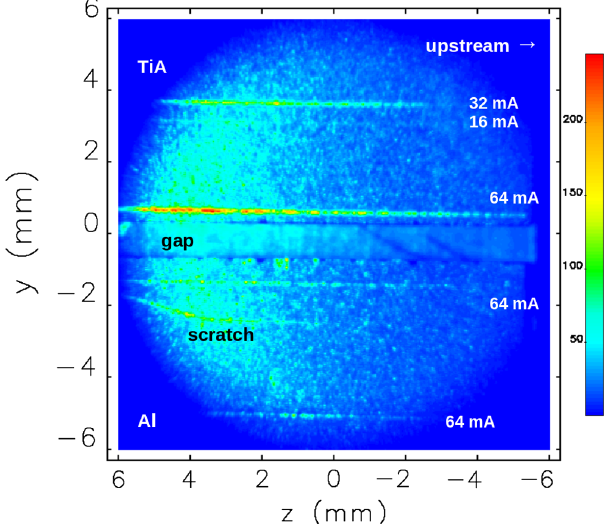
FIG. 21. Last image of the collimator surfaces after the final beam dump of the May 2019 study, shown in false color. The titanium alloy collimator test piece is above the gap and the aluminum piece is below. The field of view is 11 mm. Color indicates reflected light intensity.